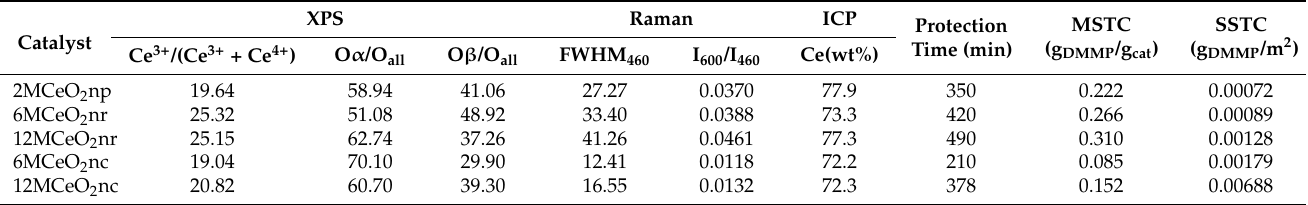
Figure 5. O1s spectra of various CeO 2 nanomaterials ( a ) 2MCeO 2 np, ( b ) 6MCeO 2 nr, ( c ) 12MCeO 2 nr, ( d ) 6MCeO 2 nc, and ( e ) 12MCeO 2 nc, red peak is attributed to O α , blue peak is attributed to O β .